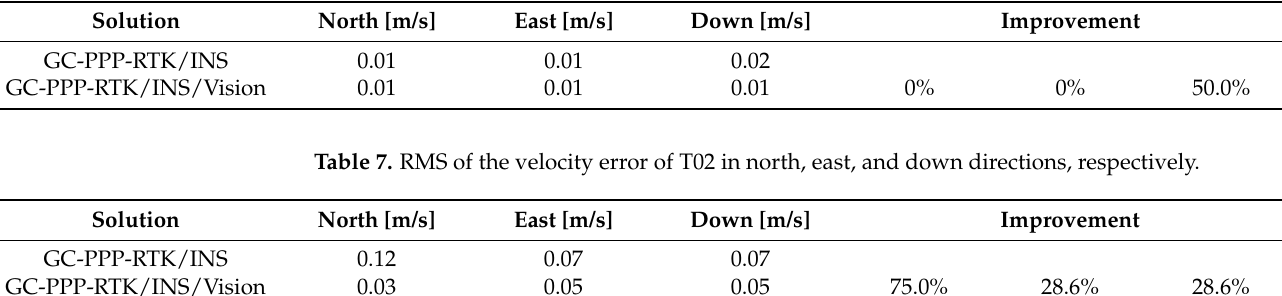
Table 6. RMS of the velocity error of T01 in north, east, and down directions, respectively.